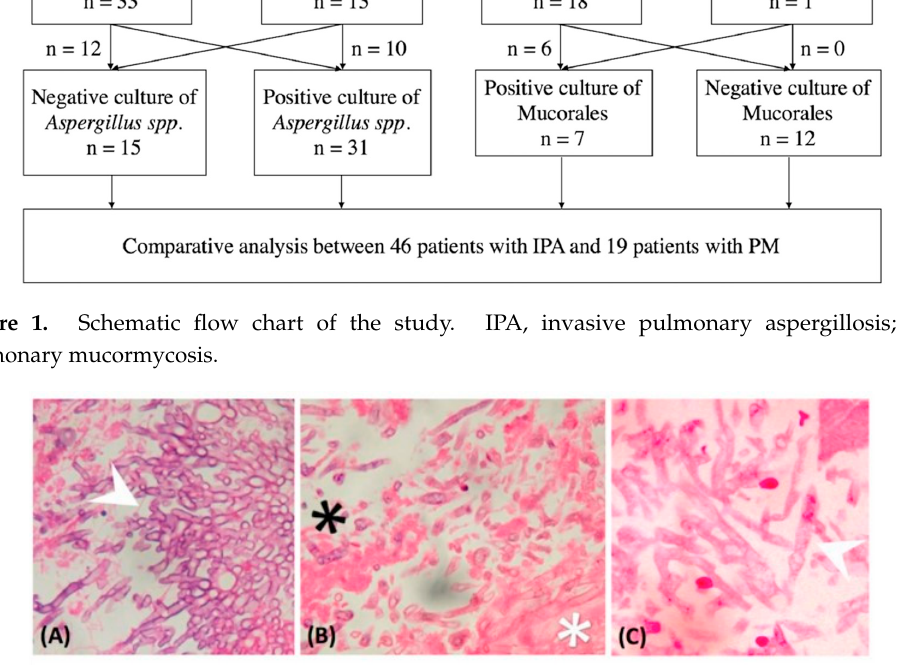
Figure 2. Histopathological finding: ( A ) Septate fungal hyphae branching at a 45° angle (arrowhead), which is characteristic of Aspergillus spp. (magnification: 400×); ( B ) broad-based, aseptate hyphae, which are characteristic of Mucormycete (white star), and the other septate fungal hyphae are Aspergillus spp. (black star) (magnification: 400×); ( C ) Mucormycete characterized with broad-based, aseptate hyphae (arrowhead) (magnification: 400×).